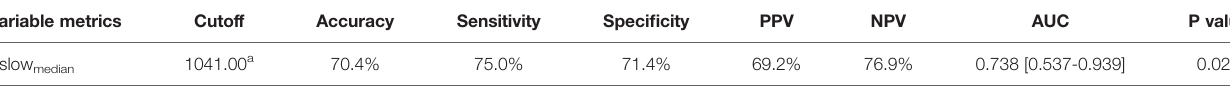
Numbers in brackets are 95% con fi dence intervals. PPV, Positive predictive value; NPV, Negative predictive value; AUC, area under the curve SRCs, Signet-ring cell carcinomas; ADC, apparent diffusion coef fi cient; and Dslow, pure molecular-based diffusion coef fi cient. a =10 -6 mm 2 /s. No differences (P >0.05) were detected by paired comparisons between ADC median and Dslow median .